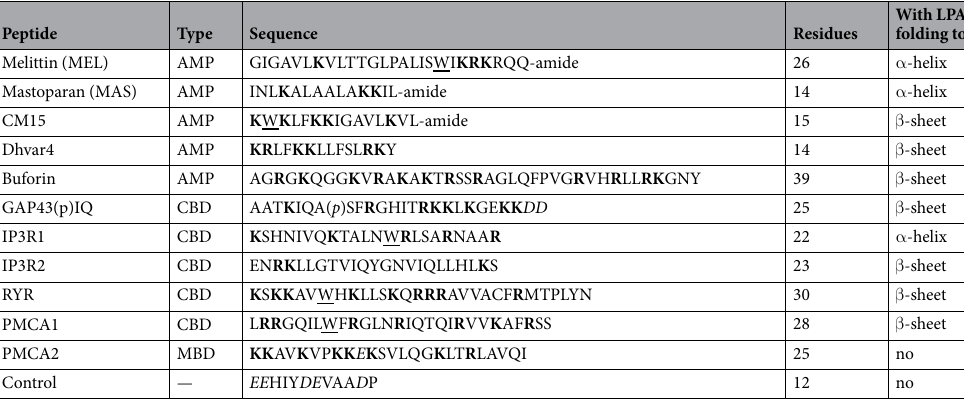
Table 1. Peptides used in the study. Peptides are classified here as antimicrobial peptide (AMP), calmodulin- binding domain (CBD), and membrane-binding domain (MBD), respectively. The group AMP involves membrane-active peptides reported to have antimicrobial activity like melittin, mastoparan, and CM15 as well as host-defense peptides like Dhvar4, and buforin. Calmodulin-binding domains are derived from the cytosolic target protein GAP43 (growth associated protein 43, peptide GAP43IQ), and membrane target proteins PMCA (plasma membrane calcium channel, peptide PMCA1), RYR (ryanodine receptor, peptide RYR), and IP3R (IP3 receptor, type 1, two peptides: IP3R1 and IP3R2). Peptide PMCA2 is the membrane-binding domain of the protein PMCA. For peptide GAP43IQ, there is a phospho-pair (peptide GAP43pIQ) bearing a phosphoryl group on the Ser where the protein GAP43 is phosphorylated in vivo . For more details see text and Methods section. Positively charged, negatively charged, and tryptophan residues in the primary sequence are bold, italic, and underlined, respectively. Secondary structure gained upon interaction with LPA is also